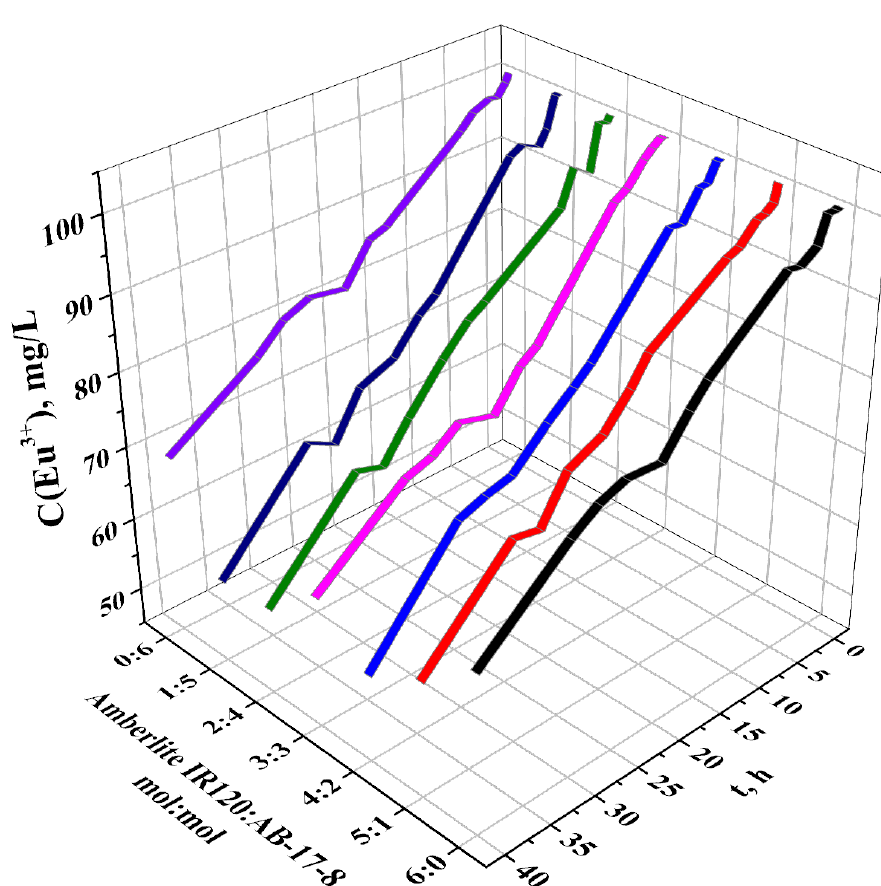
Figure 4. Change of concentration of Eu 3+ during it’s sorption by interpolymer system Amberlite IR120-AB-17-8 in dependence from molar ratios and time.